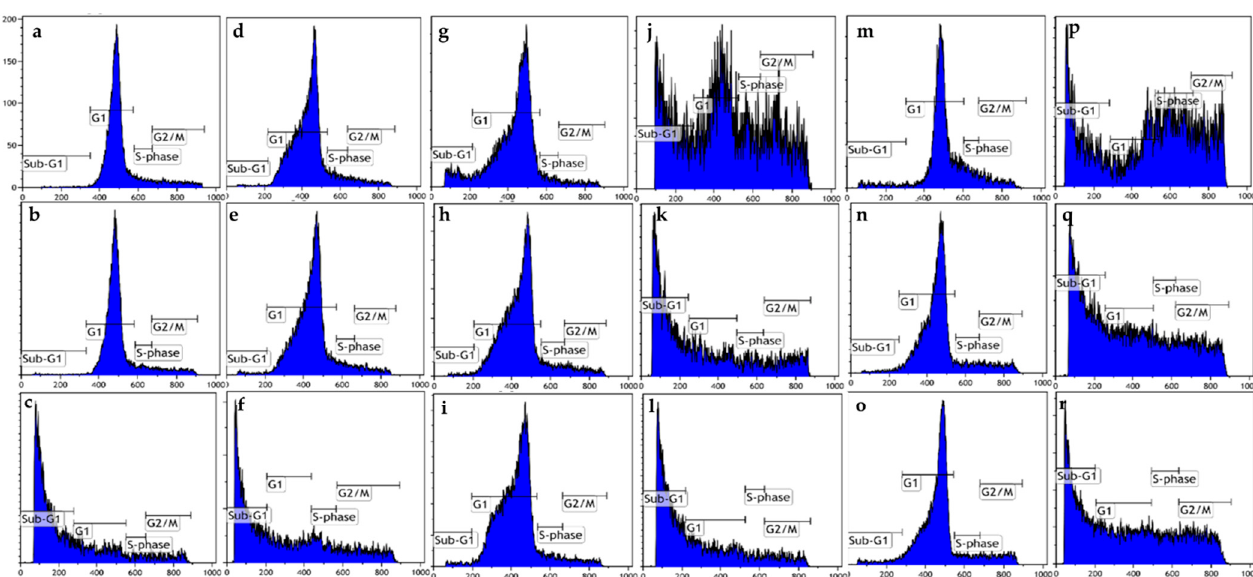
Figure 3. Cell cycle progression graphs of MCF-7 and MDA-MB-231 cells exposed to ESE-one in the presence or absence of various scavengers of reactive oxygen species (tiron, trolox and DMTU) for 48 h. ESE-one exposure resulted in a significant increase in the percentage of cells occupying the sub-G 1 phase in both MCF-7 and MDA-MB-231 cells. Tiron, trolox and DMTU exposure significantly decreased the number of cells occupying the sub-G 1 phase in MCF-7 cells and tiron as well as DMTU exposure significantly decreased the number of cells present in the sub-G 1 phase in MDA-MB-231 cells. Tiron, trolox and DMTU significantly decreased the number of cells in the G 2 /M phase in MDA-MB-231 cells and only tiron had a significant effect in MCF-7 cells. ( a ) MCF-7 cells cultured in complete growth medium, ( b ) vehicle-treated MCF-7 cells, ( c ) MCF-7 cells exposed to ESE-one only, ( d ) MDA-MB-231 cells cultured in complete growth medium, ( e ) vehicle-treated MDA-MB-231 cells, ( f ) MDA-MB-231 cells exposed to ESE-one, ( g ) MCF-7 cells exposed to tiron only, ( h ) MCF-7 cells exposed to trolox only, ( i ) MCF-7 cells exposed to DMTU only, ( j ) MCF-7 cells coexposed to tiron and ESE-one, ( k ) MCF-7 cells coexposed to trolox and ESE-one, ( l ) MCF-7 cells coexposed to DMTU and ESE-one, ( m ) MDA-MB- 231 cells exposed to tiron only, ( n ) MDA-MB-231 cells exposed to trolox only, ( o ) MDA-MB-231 cells exposed to DMTU only, ( p ) MDA-MB-231 cells coexposed to tiron and ESE-one, ( q ) MDA-MB-231 cells coexposed to trolox and ESE-one, ( r ) MDA-MB-231 cells coexposed to DMTU and ESE-one. Table 3. Percentage of MCF-7 cells occupying each cell cycle phase as determined by means of flow cytometry using propidium iodide after 48 h exposure. An asterisk (*) indicates p -value ( p < 0.05) compared to ESE-one treated cells.